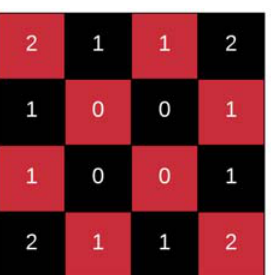
Figure 3: 2D Analogue of MPI Message Count Numbering that Dictates Solution Order